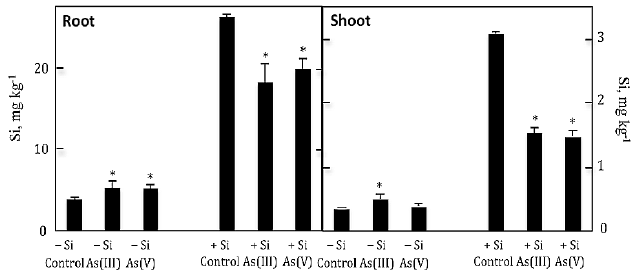
Fig. 2: Silicon concentration in root and shoot of lettuce after cultivation for five days in 0 and 1 mM potassium silicate with or without 10 μM arsenite (AsIII) or arsenate (AsV); n = 9, ±SE. * indicate significant difference from control.